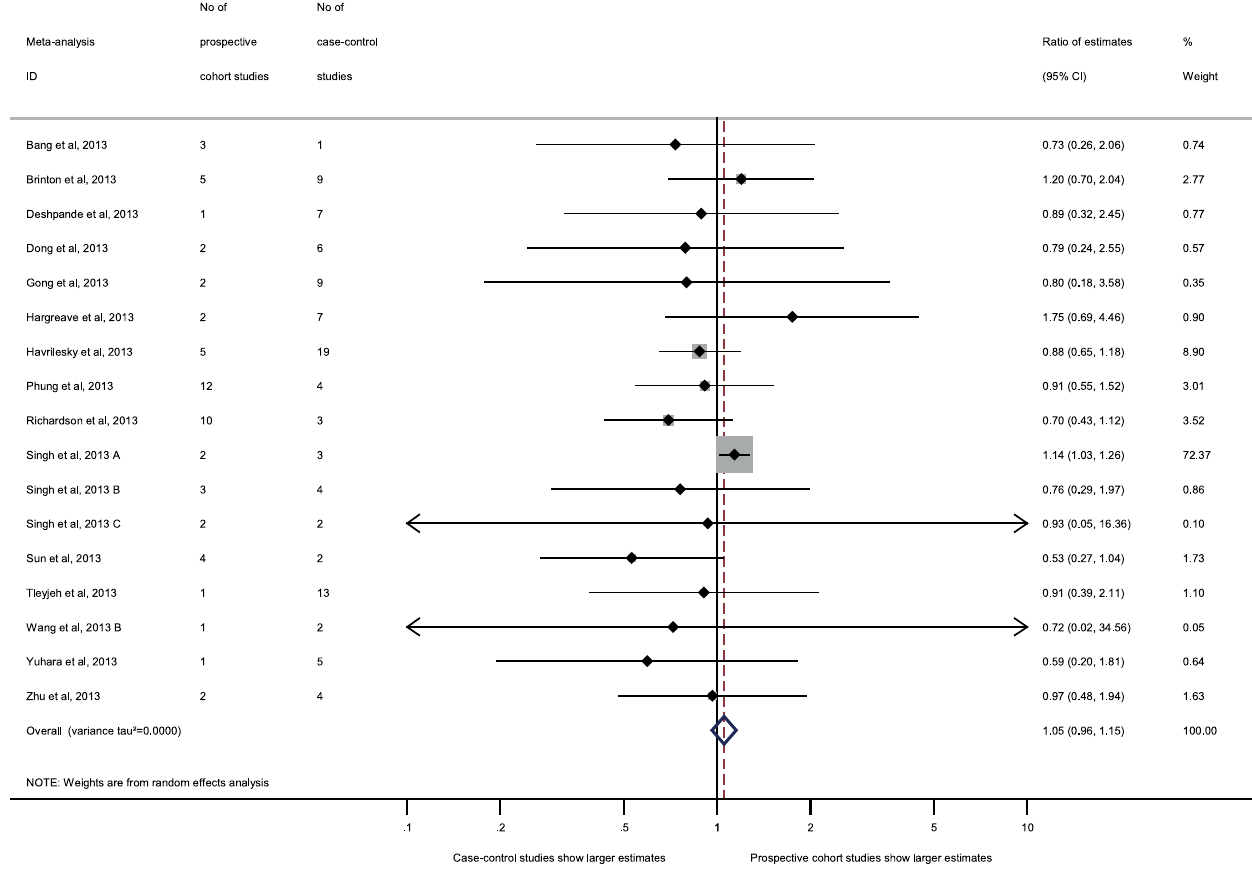
Fig 4. Secondary analysis of differences in effect estimates between case – control and prospective cohort studies. Difference in treatment effect estimates is expressed as ratio of estimates (RE). A RE < 1 indicates that case – control studies yielded larger estimates of the intervention effect or adverse events than prospective cohort